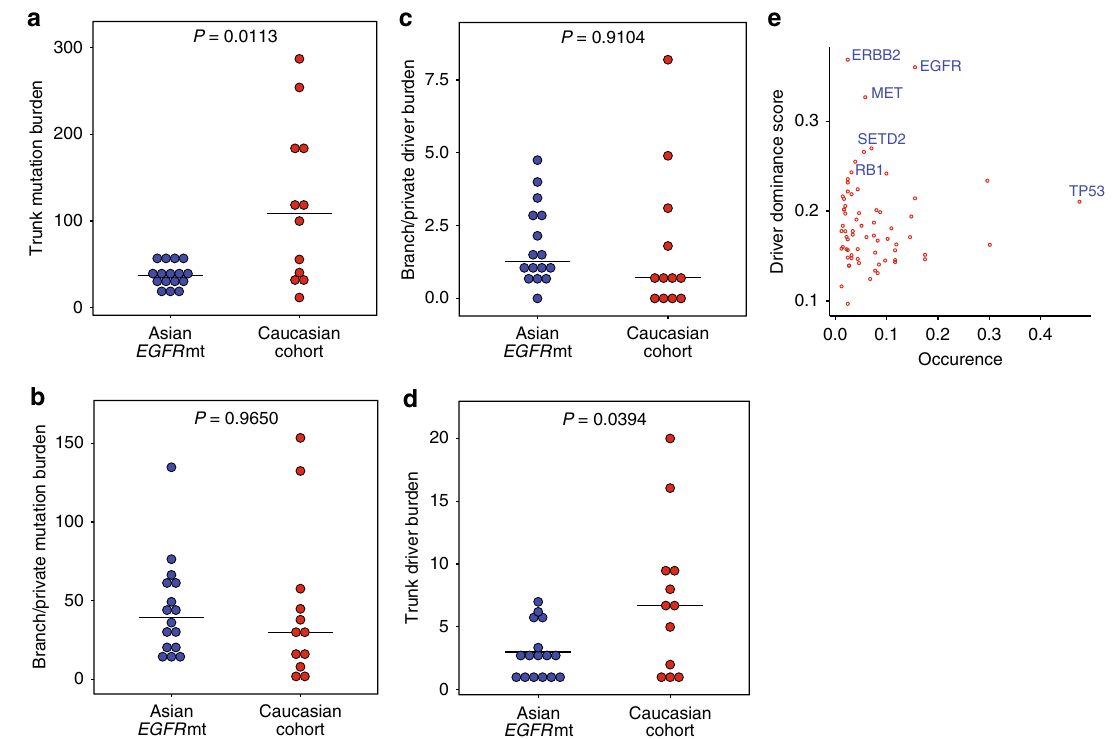
Fig. 3 EGFR is a dominant driver with few co-drivers. Dot plots comparing mutation burden on a trunk and b branches between the Asian EGFR -mutant and smoker dominated Caucasian cohorts 19, 20 . c Dot plot comparing number of branch/private mutated drivers (extended driver list) between the EGFR- mutant and smoker dominated Caucasian cohorts 19, 20 . Welch ’ s t -test was used to compare the two groups. d Dot plot showing that EGFR -mutant LUADs have signi fi cantly fewer truncal drivers (extended driver list; Welch ’ s t -test) compared to smoker Caucasian LUADs. Three random sectors were picked 20 times iteratively and averages of the iterations are represented as circles in a – d . Horizontal line indicates the median for that cohort. e “ Driver dominance score ” measuring driver self-suf fi ciency for each of 78 LUAD driver genes calculated across published 412 tumors 3, 4 is plotted against the fraction